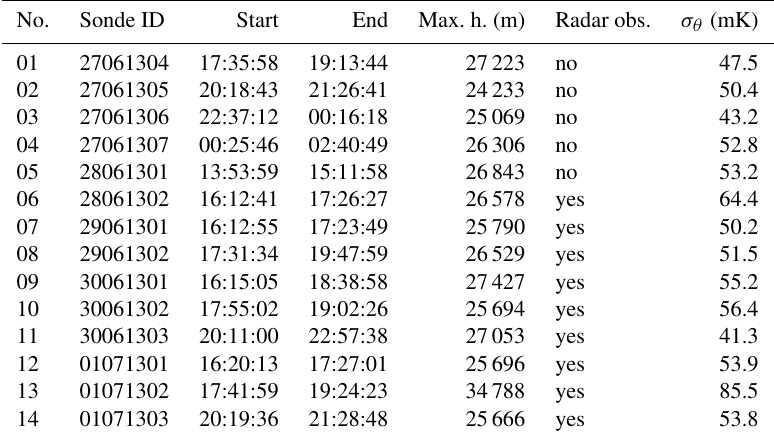
Table 2. Basic information of the 14 radiosondes including the launch and end times (UTC), the maximum height (m), the simultaneous radar measurements for comparison, and the measurement noise